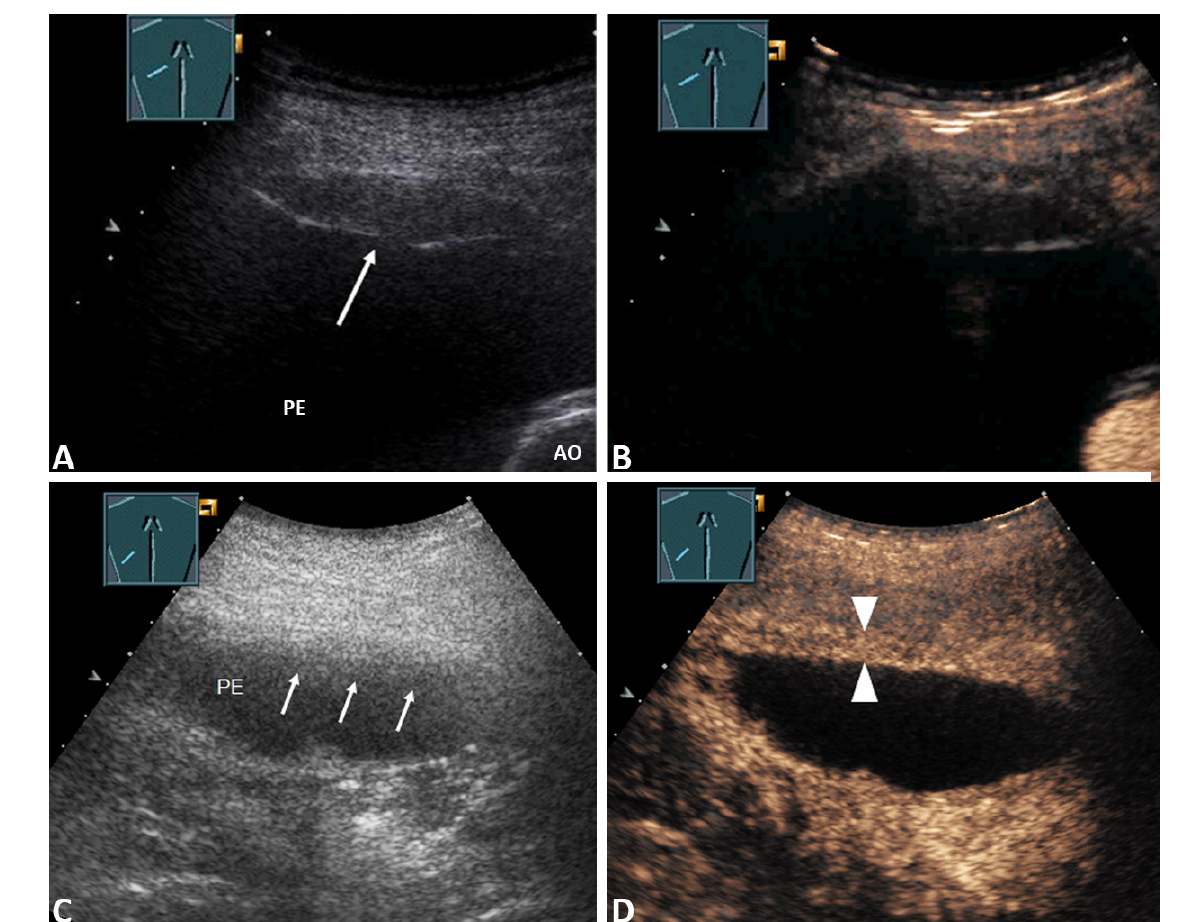
Figure 3. ( A ) 74-year-old patient with decompensated heart failure and a right-sided PE. The effusion cytology is negative. Pleural thickening is conspicuous in the B-TUS images (arrow); ( B ) CEUS shows pleural thickening with no enhancement; the final diagnosis was a benign PE with pleural thickening, based on histologically confirmed fibrinous pleuritis. AO = Aorta. ( C ) 75-year-old patient with chronic obstructive pulmonary disease, fever, and a left-sided narrow PE. The effusion cytology was negative. B-US shows conspicuous fuzzy pleural thickening (arrows); ( D ) CEUS reveals sharp pleural thickening with marked enhancement (sticks). The final diagnosis was a benign PE due to empyema. In those with nodular pleural thickening, 11/12 (91.7%) cases had malignant PEs, and